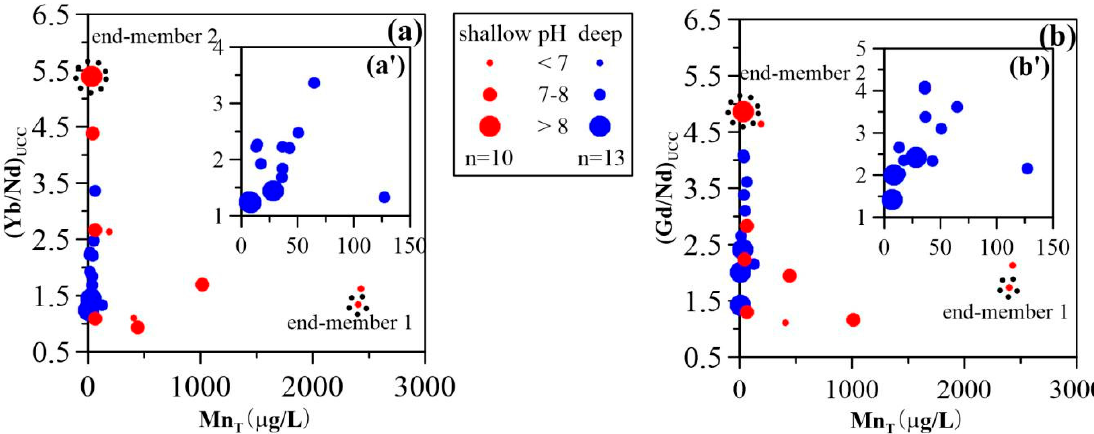
Figure 8. ( a ) (Yb/Nd) UCC ratio ( b ) (Gd/Nd) UCC ratio as a function of total Mn concentrations (Mn T ) for shallow and deep groundwater (UCC values are from McLennan [36]) (REE, Mn T and Fe T concentrations were determined by experiments).